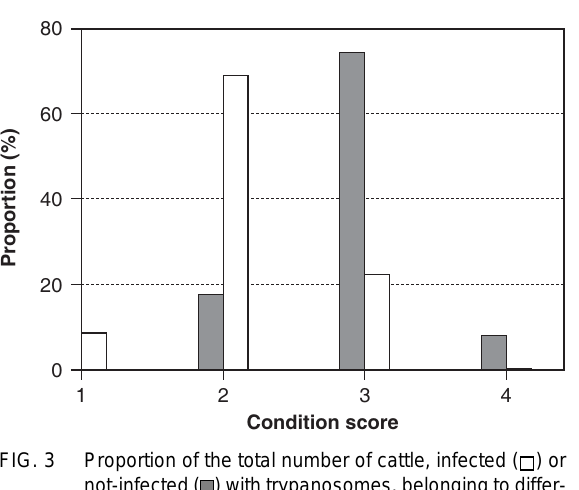
FIG. 3 Proportion of the total number of cattle, infected ( ) or not-infected ( ) with trypanosomes, belonging to differ- ent body condition scoring categories